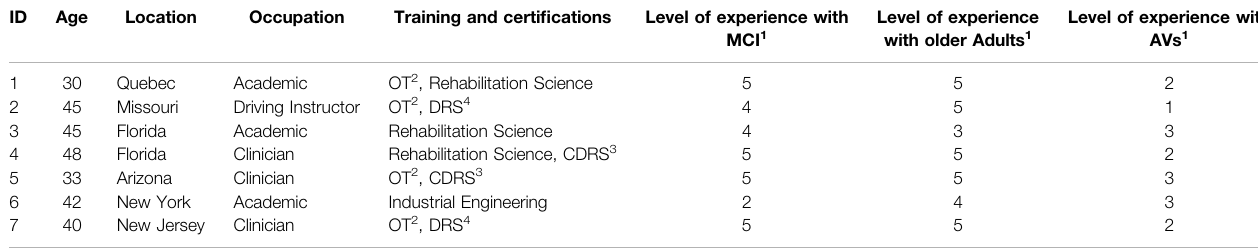
TABLE 1 | Demographics and background information of subject matter